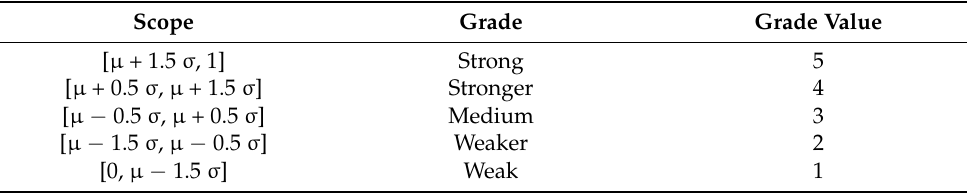
Figure 11. Distribution of agricultural disaster-pregnant environment integrated index. Table 5. Mean-standard deviation method of